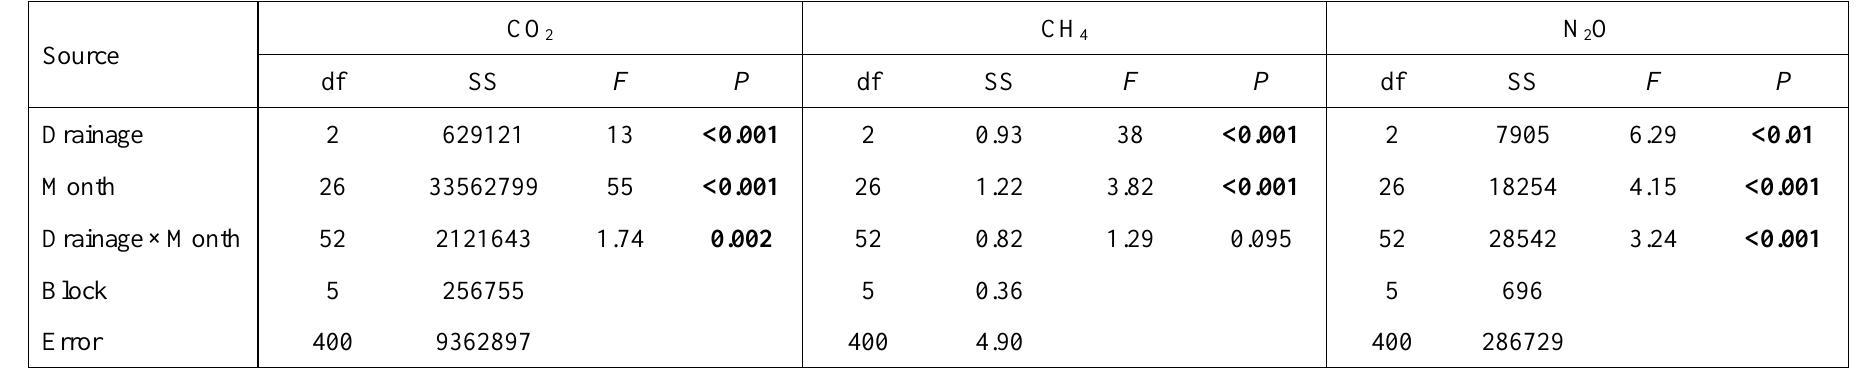
Table A2. Results (Degrees of freedom (df), Sum of squares (SS), F values and P values) of the Linear Mixed Model (LMM) showing the effects of drainage treatment (Drainage), monitoring month (Month) and their interactions on emission rates of carbon dioxide (CO years. Values are considered significant if P < 0.05 (in bold type).